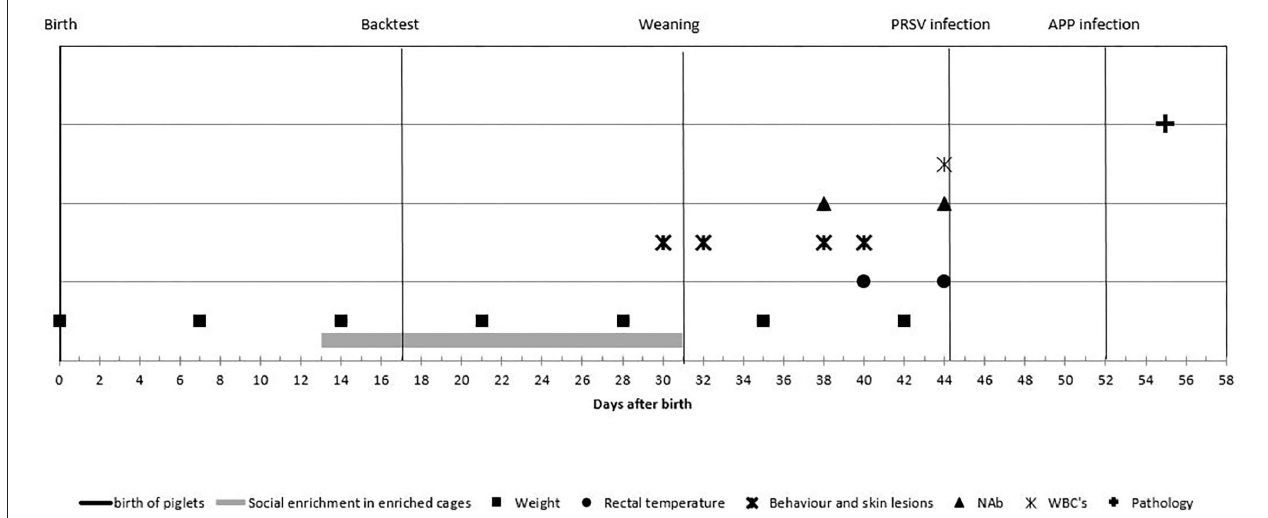
FIGURE 2 | Experimental process and timeline of the measurements: piglets were observed from birth until 55 days of age. Enriched housed pigs experienced social enrichment from day 13 until weaning; coping strategy was assessed at day 17. Piglets were weaned at day 31 and infected with porcine reproductive and respiratory syndrome virus (PRRSV) at day 44 and with Actinobacillus pleuropneumoniae at day 52 and euthanized at day 55. Body weight was measured weekly; rectal temperature was measured at days 40 and 44; behavior and skin lesions were assessed at days 30, 32, 38, and 40. Natural antibodies (NAbs) were measured at days 38 and 44; white blood cell (WBC) at day 44 and histological lung lesion scores were assessed after day 55.